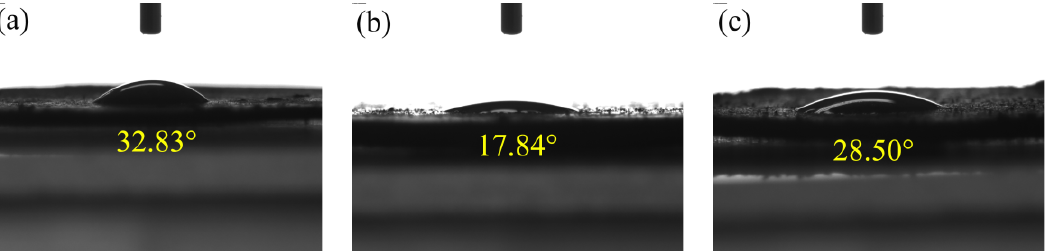
Figure 9. Contact angles of flotation products and feedstock. ( a ) OPFC samples, ( b ) OPFT samples, and ( c ) FEBFS samples.